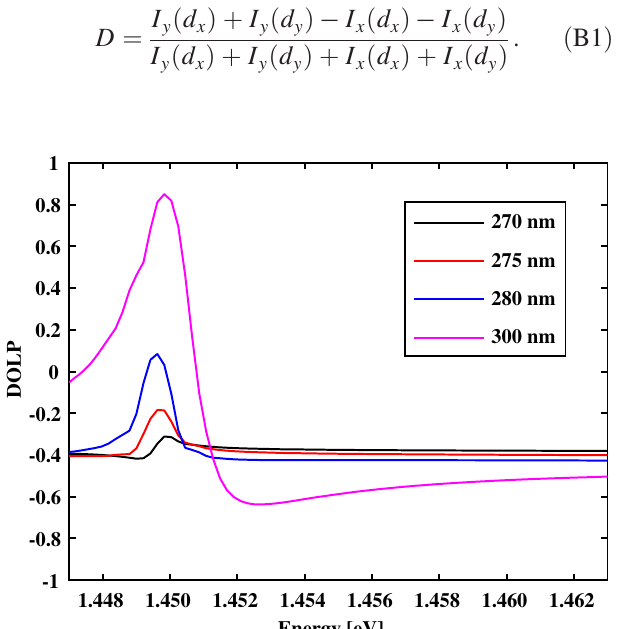
FIG. 17. 3D FEM modeled DOLP for different Δ . (a) DOLP modeled using 3D FEM method considering the QD recess. (b) DOLP modeled using 3D FEM method when ignoring the QD recess. DOLP in (a) and (b) was calculated as in Fig.